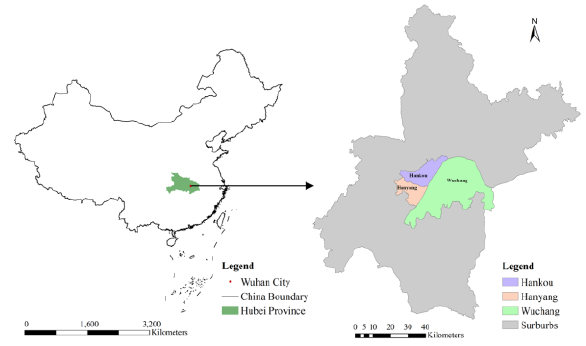
Figure 1. Location and administrative division of Wuhan City.